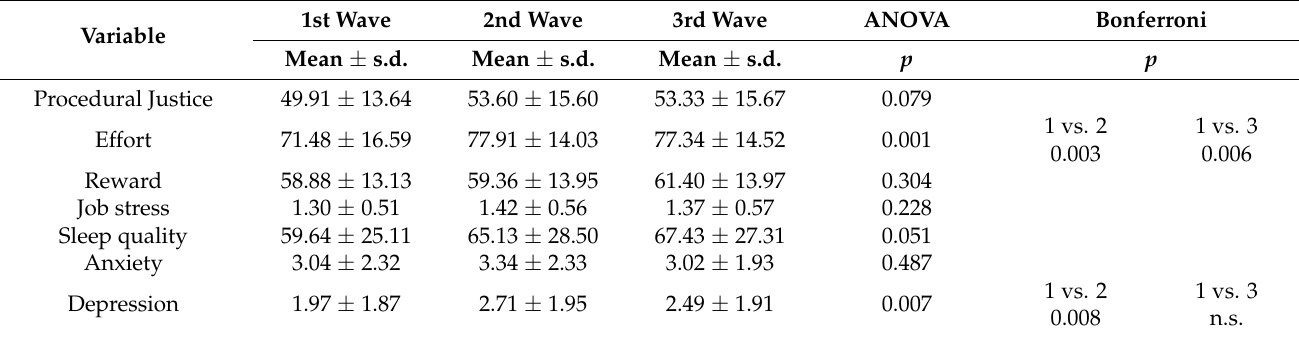
Table 3. Mental health indicators (perceived justice, occupational stress, sleep quality, anxiety, depression) in anaesthesiolo- gists during the three waves of the COVID-19